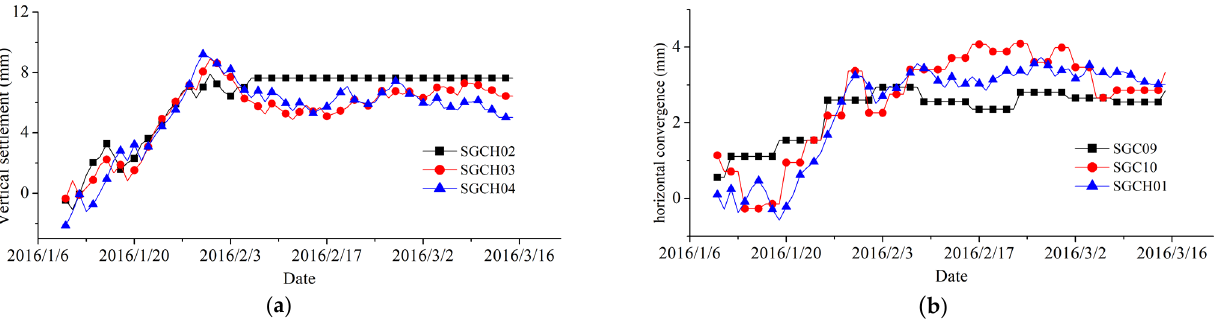
Figure 22. Monitored tunnel deformation. ( a ) Vertical settlement. ( b ) horizontal convergence.